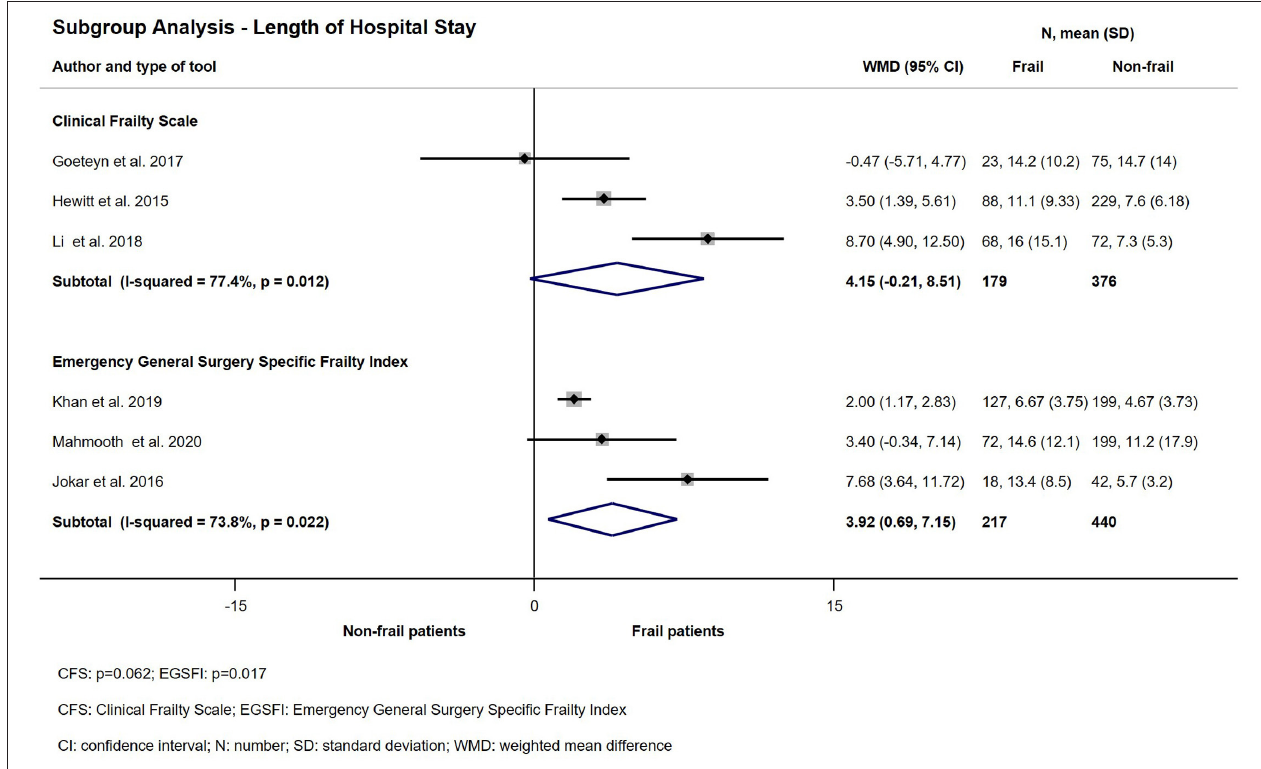
FIGURE 8 | Subgroup analysis—Length of hospital stay for emergency surgical patients living with frailty compared to non-frail patients. Frail patients’ average length of hospital stay was higher than non-frail patients’ (CFS: WMD: 4.15; CI: − 0.21–8.51) and (EGSFI: WMD: 3.92; CI: 0.69–7.15). Please note the considerable